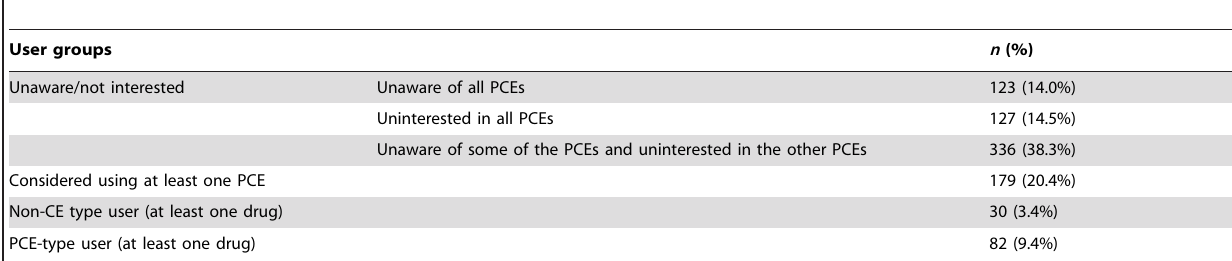
Table 5. n =877. User group categories on the basis of familiarity with methylphenidate, modafinil and Adderall.